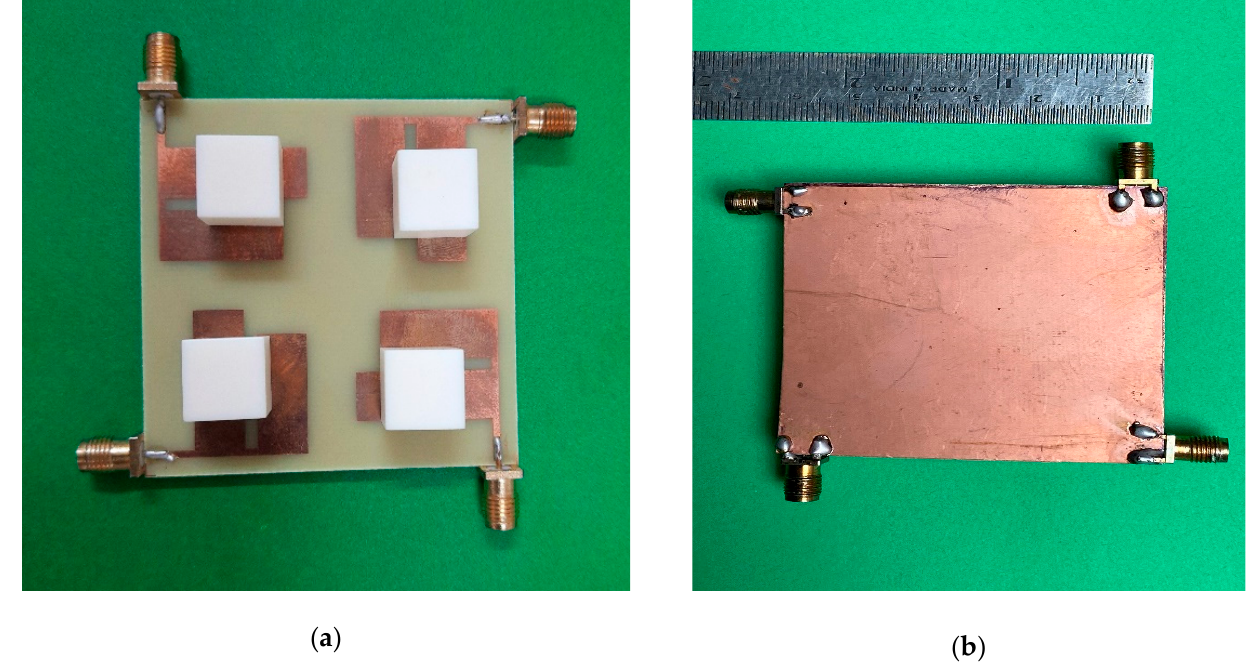
Figure 6. Fabricated DRA Prototype. ( a ) Top View; ( b ) Back View. A Keysight E5063A vector network analyzer (VNA) was used to measure the S- parameters of the proposed antenna. These measured results were not the same as the simulated results. The difference in the results was mainly due to manufacturing